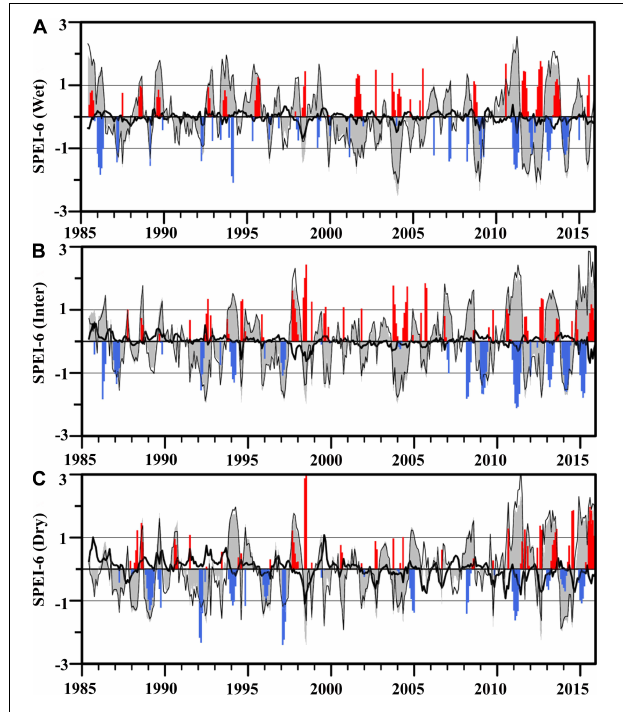
FIGURE 3 | Time series of SPEI-6 (shaded) and SPI-6 (thin black line) for (A) wet, (B) intermediate, and (C) dry regions in Mahaweli river basin (MRB) from 1985 to 2015. The difference between the two indices (SPEI-6 minus SPI-6) is depicted by the thick black line. The drought event is defined when SPEI-6 or SPI-6 value is smaller than –1, and the wet event is defined when SPEI-6 or SPI-6 value is larger than 1. The positive and negative anomalies of cumulative 6-months temperature are displayed by red and blue bars, respectively. The letter Wet, Int, and Dry represent wet, intermediate, and dry regions in MRB,